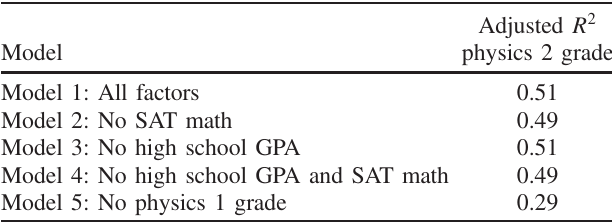
TABLE III. Adjusted coefficients of determination (adjusted R 2 ) for physics 2 grade in the five different models. All p values are < 0 . 001